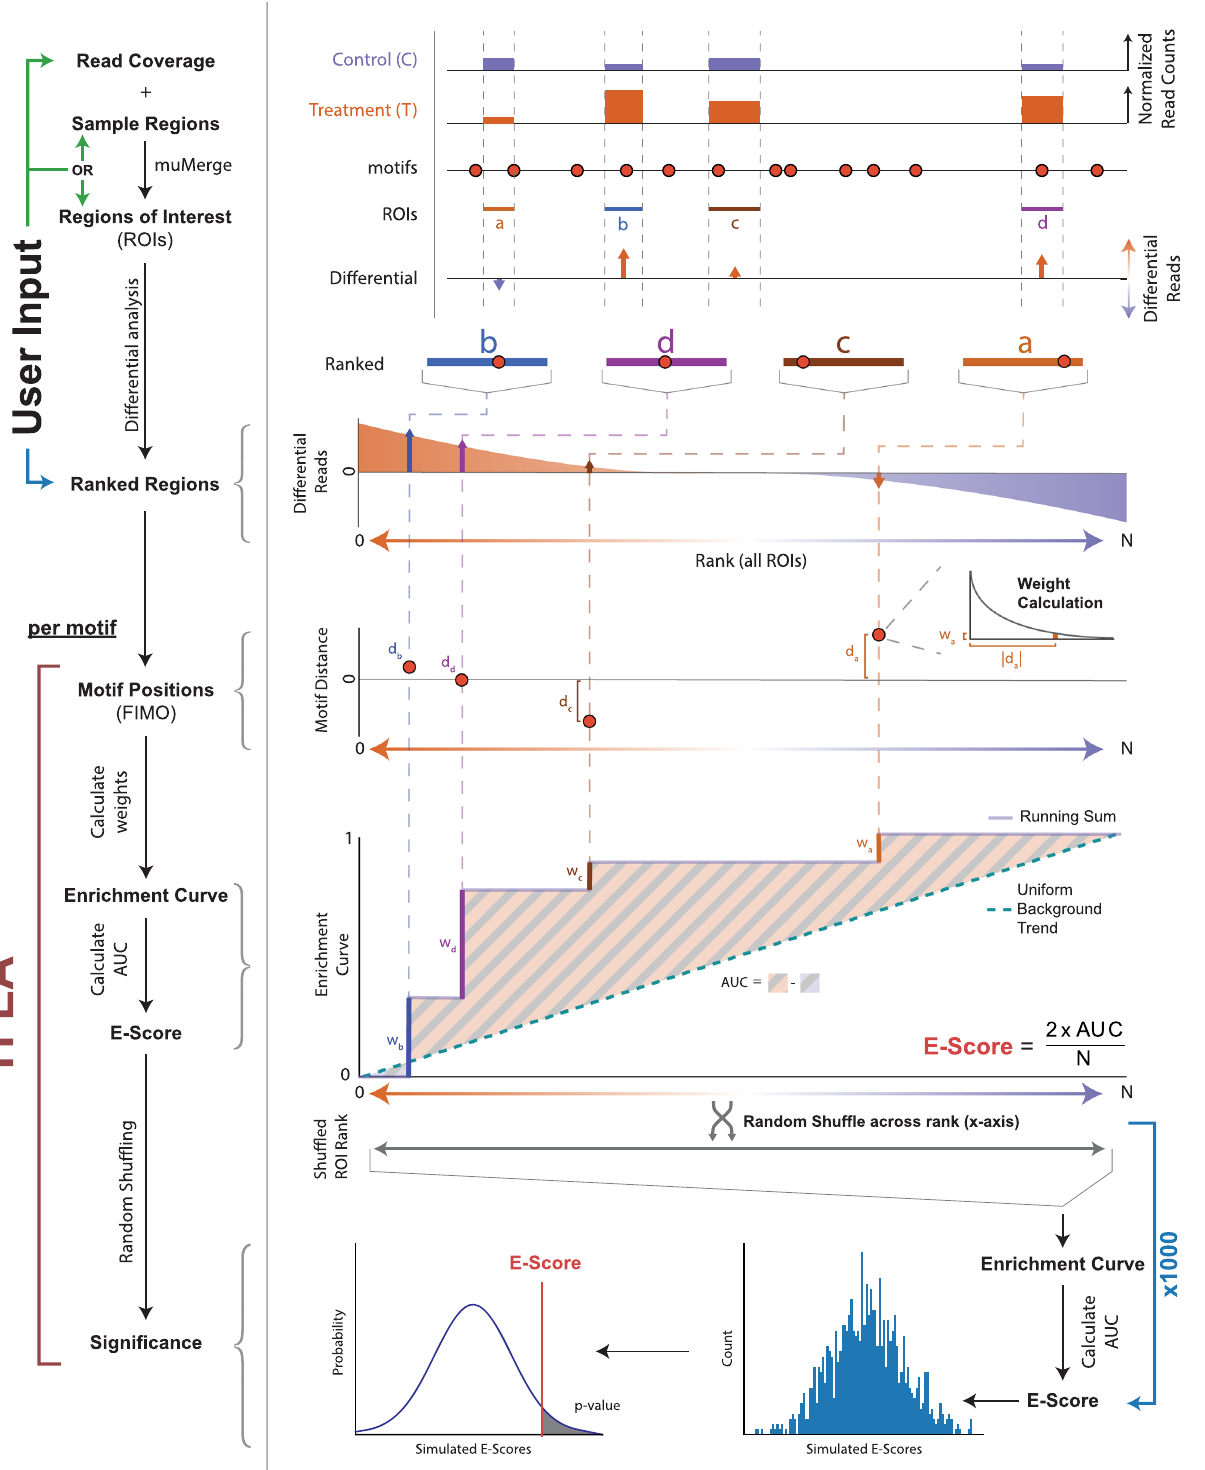
Fig. 1 TFEA calculates motif enrichment using differential and positional information. The TFEA pipeline requires, minimally, a ranked list of ROIs (control in blue, treatment in orange). Optionally, a user may provide raw read coverage and regions (ROI, colored boxes labeled a – d ), in which case TFEA will perform ranking using DESeq 2,43 analysis. With a set of ranked ROIs (orange up, blue down), TFEA analyzes motif enrichment for each motif provided (red circles). For each motif, positions are determined by FIMO scans, and an enrichment curve is calculated by weighting each motif instance (with weight w i , using an exponential decay as a function of the motif distance d i from the region center) and adding this value to a running sum. An E -score is calculated as 2 * AUC, e.g., the area under the enrichment curve between the running sum and a uniform background (dashed line), and scaled by the number of motif instances N . For statistical signi fi cance, the ROI rank is randomly shuf fl ed 1000 times, and E -scores are recalculated for each shuf fl e. The true E -Score is then compared to the distribution of E -Scores obtained from the shuf fl ing events. For example, the output of TFEA, see Supplementary Fig. 1 and Supplementary Fig. 2.